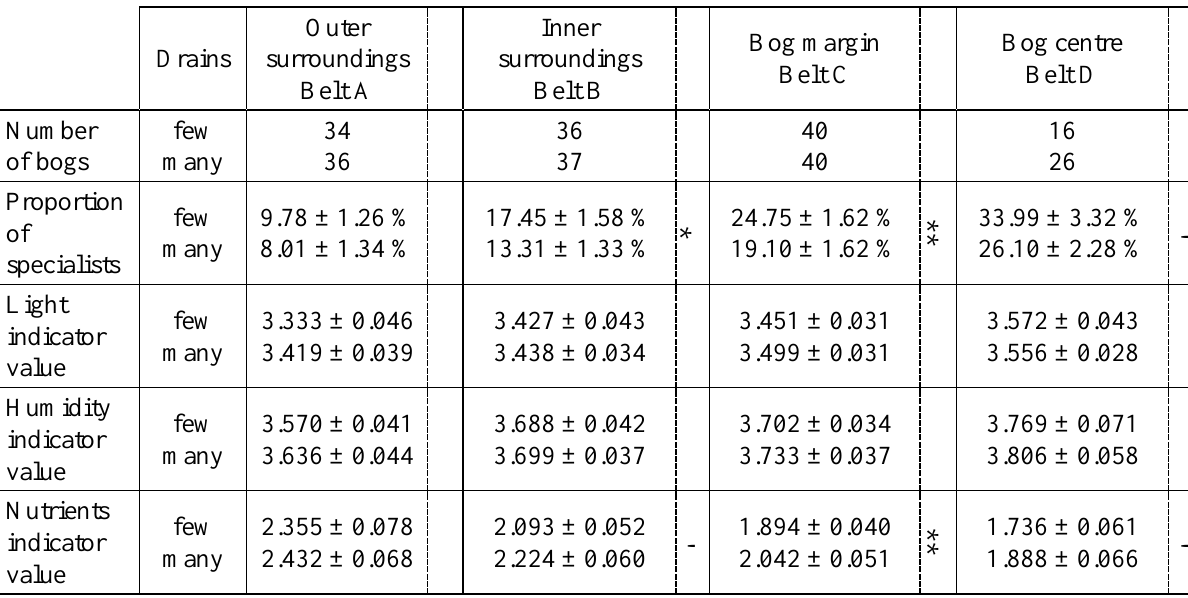
Table 6. Site conditions in Belts A, B, C and D for bogs with few and many draining structures. Significance levels for the differences between bogs with few and many draining structures (rank sum test): *** < 0.001, ** <0.01, * <0.05, ' <